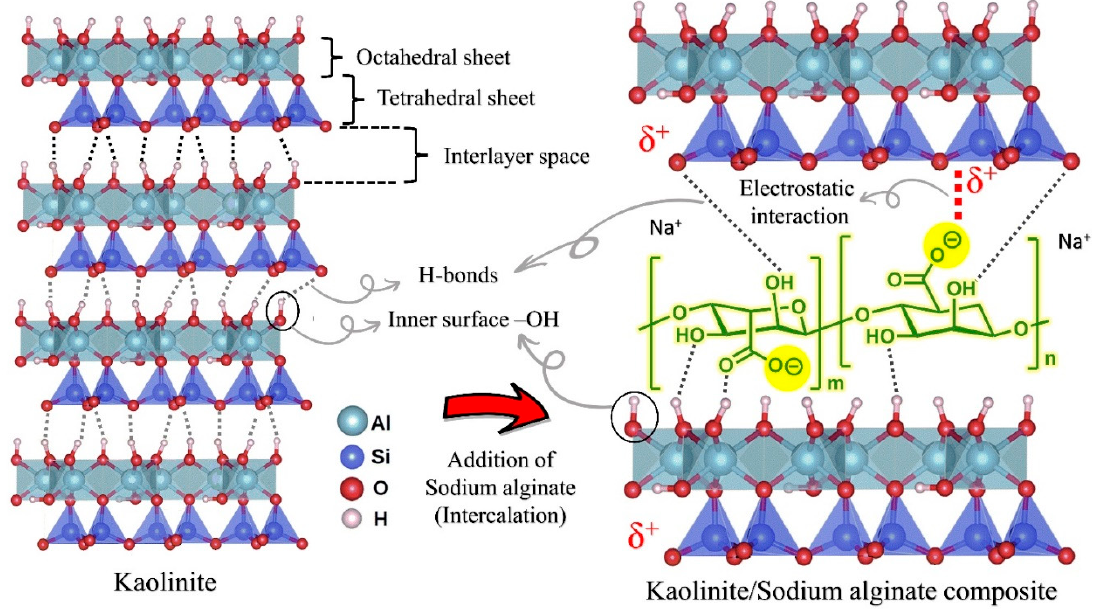
Figure 10. Molecular structure of sodium alginate, kaolinite and their interactions.